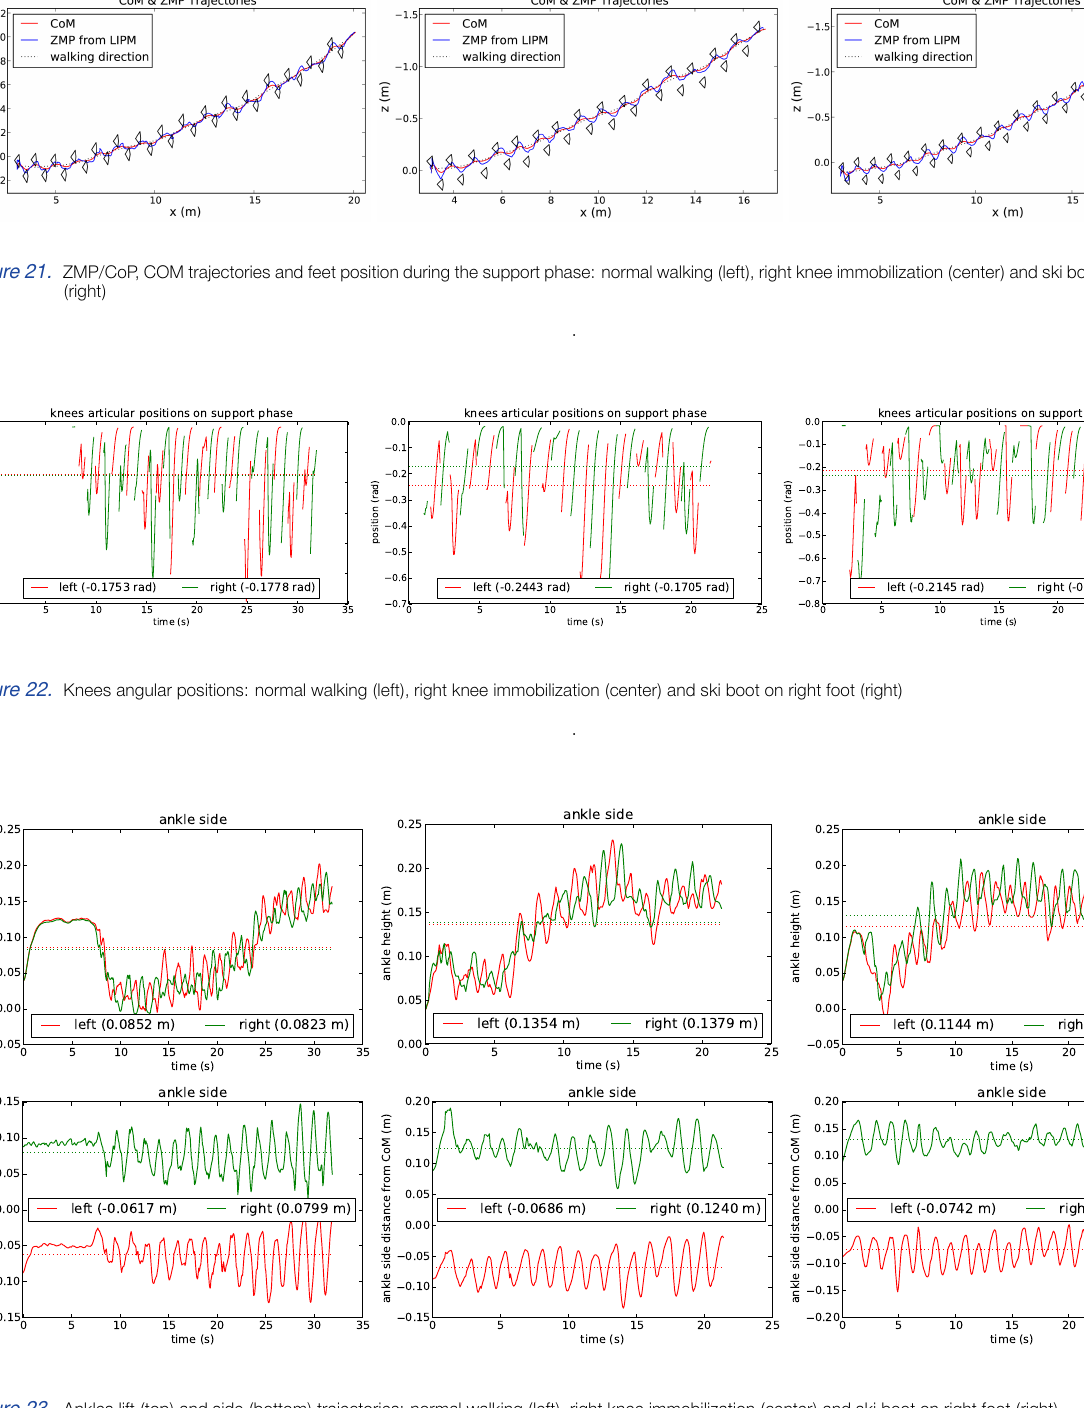
Figure 23. Ankles lift (top) and side (bottom) trajectories: normal walking (left), right knee immobilization (center) and ski boot on right foot (right)